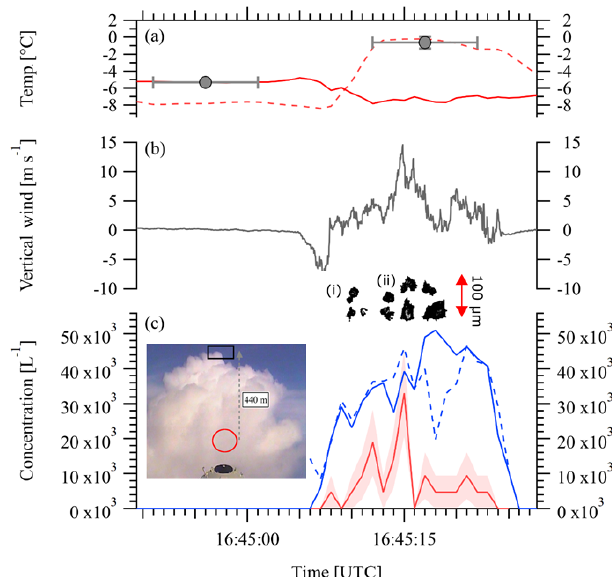
Figure 5. Time series from penetration 1. (a) In situ measured tem- perature from the Rosemount de-iced sensor (solid red line), derived temperature (dashed red line), mean derived temperature in cloud (grey marker) and mean in situ measured temperature out of cloud before penetration (grey marker). Error bars show the mean value integration period ( x axis) and measurement error where applica- ble ( y axis). (b) Vertical wind speed velocity (grey line) and (c) liq- uid drop concentration from the HALOHolo (blue solid line), liquid drop concentration from the CDP (blue dashed line) and ice crys- tal concentration (multiplied by 1000 for comparison with liquid concentrations) from the HALOHolo (red solid line). Superimposed imagery is included for ice crystals measured by the HALOHolo at time points 16:45:12UTC (i) and 16:45:15UTC (ii) and from the forward-facing camera on the aircraft prior to penetration.